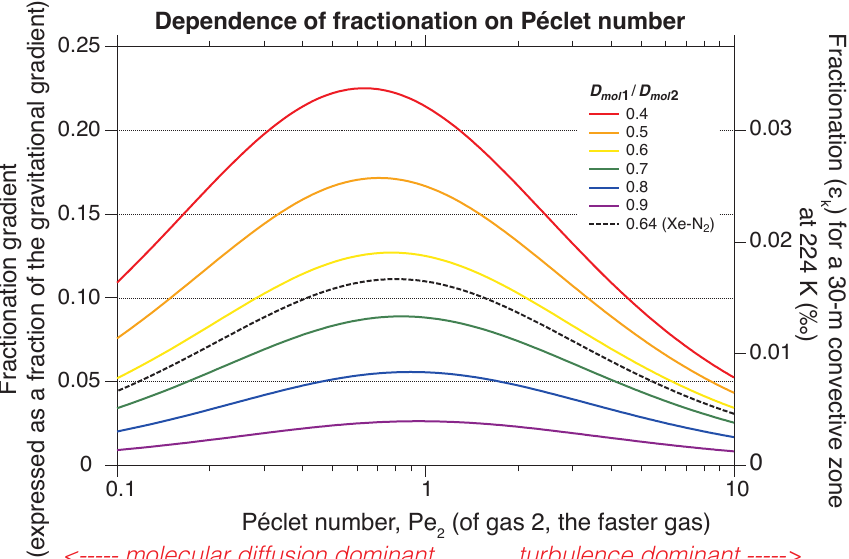
Fig. 2. Prediction of simple theory for dependence of fractionation on the Péclet number. The horizontal axis is the smaller of the two Péclet numbers, or that of the faster-diffusing gas. Different molecular diffusivity ratios are shown in different colors, as indicated by legend. For example, a diffusivity ratio of 0.64 would have a maximum fractionation equivalent to about 11% of the equilibrium gradient. The values for 136 Xe- 28 N 2 are shown in the dashed black line. These calculations presuppose that Pe is constant with depth within the convective